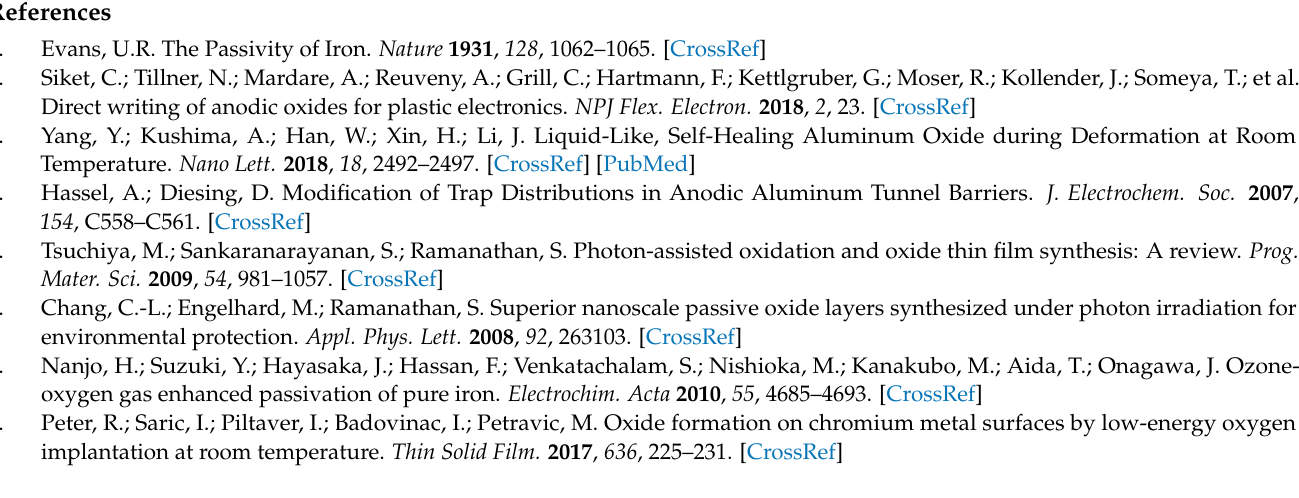
discharge; Figure S2: XPS survey spectra of the RNO-10h 316L SS. Figure S3: XPS spectra of the Table S1: EIS parameters extracted by fitting EIS